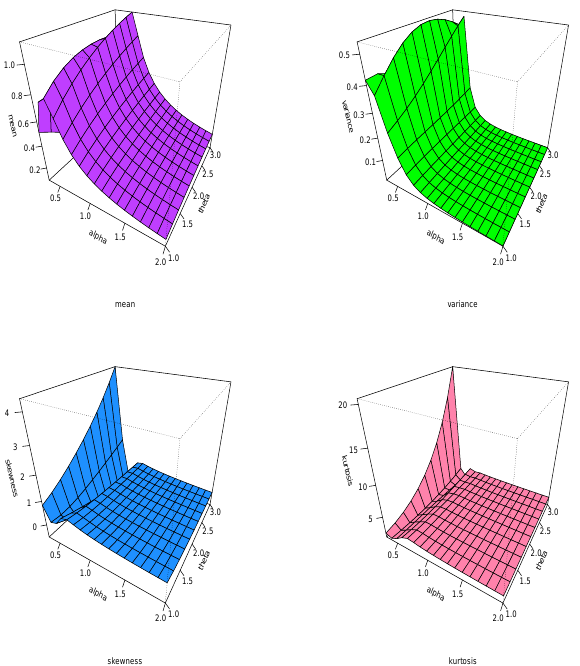
Figure 5. Three-dimensional plots of M ( X ) , Var ( x ) , CS ( x ) and CK ( x ) of the SBXL distribution for β = 0.5.